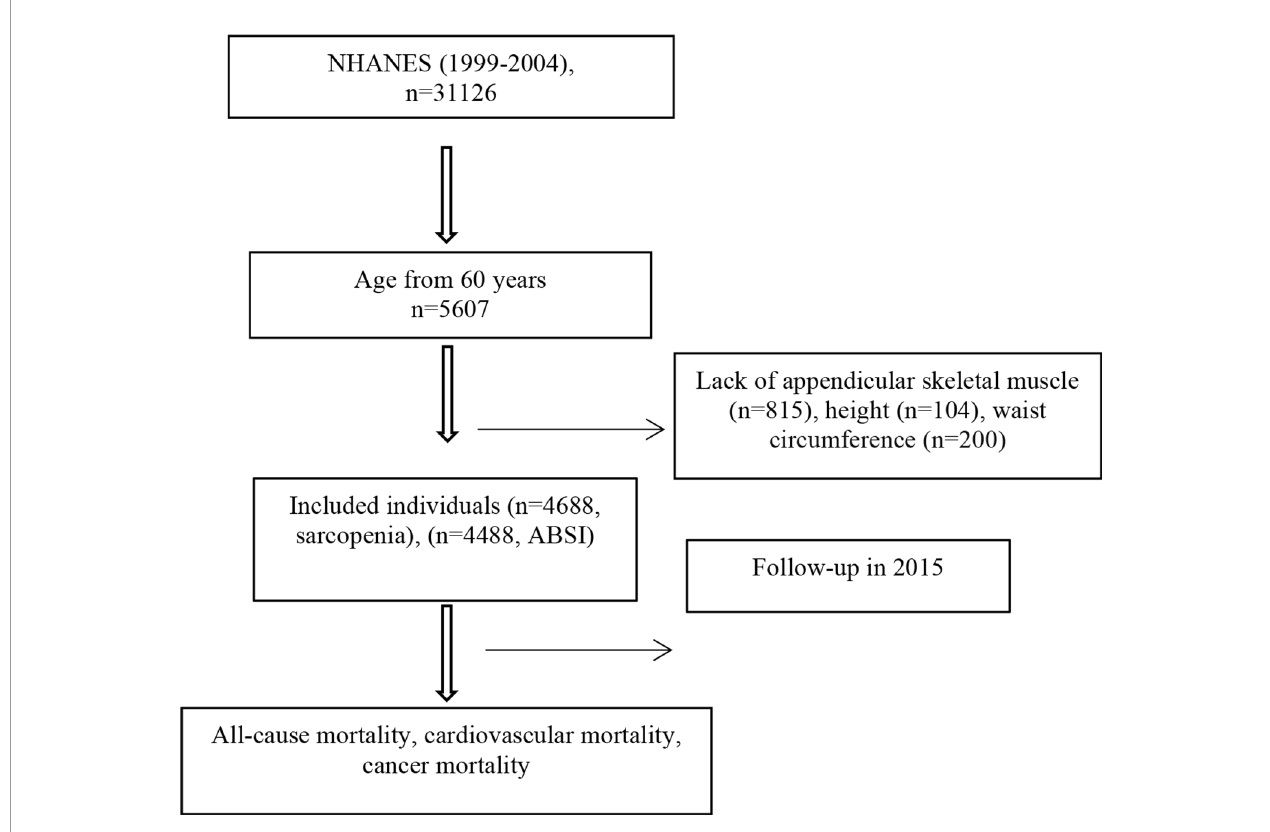
FIGURE 1 | Study chart for analysis ( n =